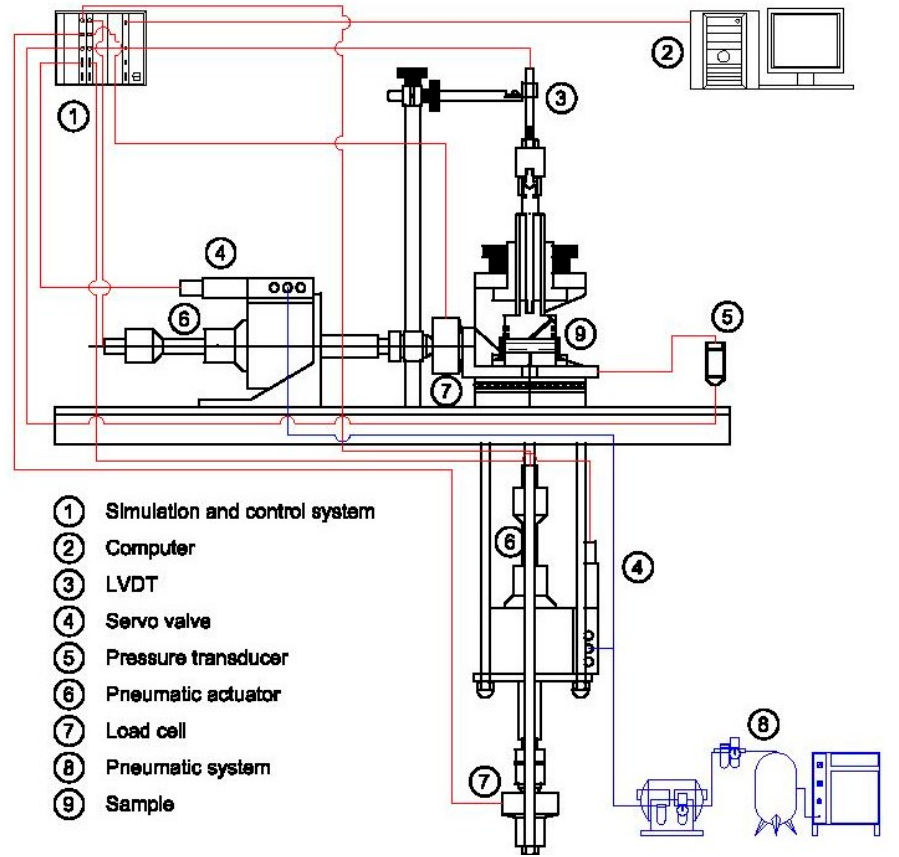
Figure 3. Scheme of the mechanism for the application of axial and tangential loads.